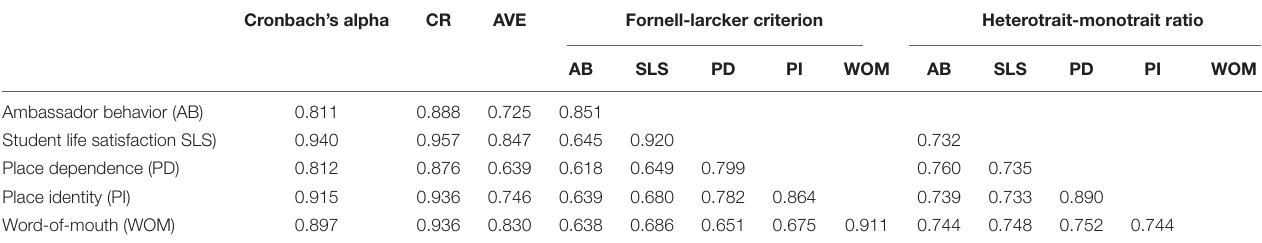
TABLE 4 | Reliability, construct validity, and correlation.